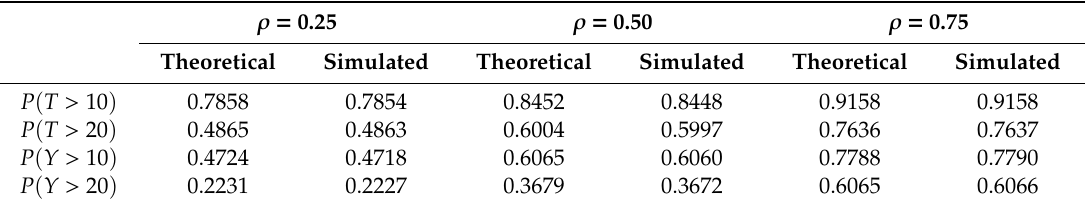
Table 3. Comparisons between theoretical and simulated results for probabilities that a real customer spends more than 10 time units and more than 20 time units in the system and queue. ρ = 0.25 ρ = 0.50 ρ = 0.75 Theoretical Simulated Theoretical Simulated Theoretical